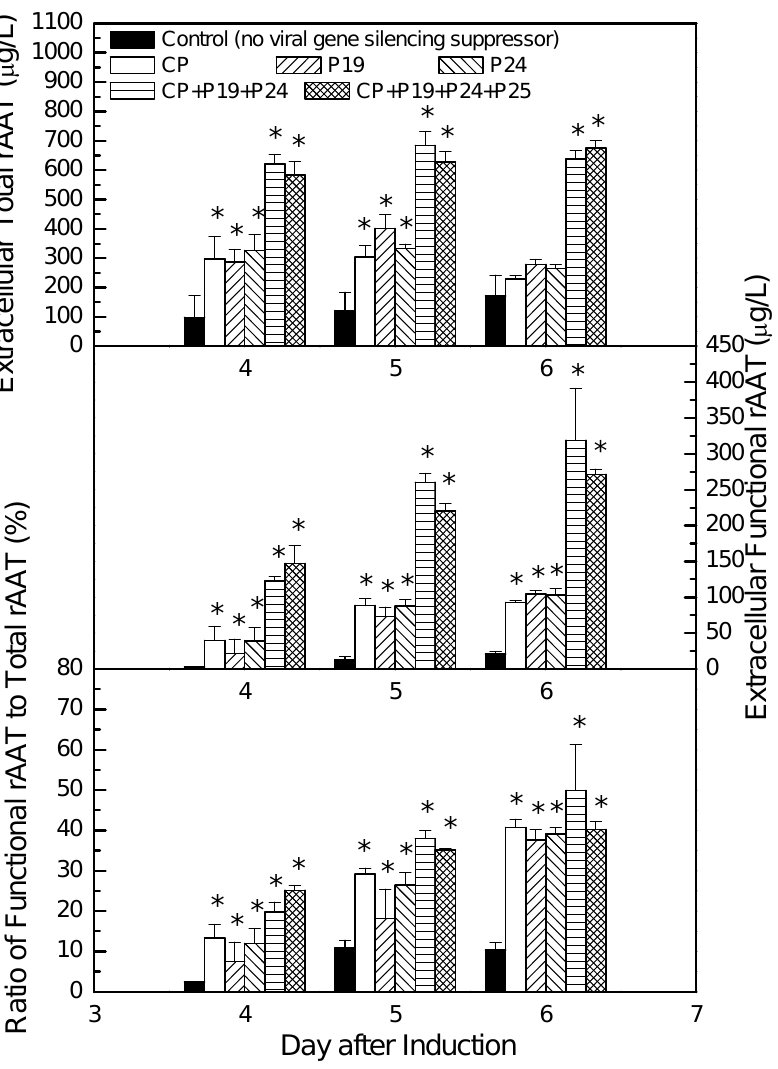
Figure 10. Comparisons of the rAAT yield and functionality in transgenic CMViva cell culture co-cultivated with individual or combined recombinant Agrobacterium carrying viral gene silencing suppressor (CP, P19, P24 or P25). Error bars represent one standard deviation of measurements obtained from triplicate sample assays of duplicate experiments. An asterisk shown on the graphs indicates that there is a statistically significant difference from the control group ( p ≤ 0.05).